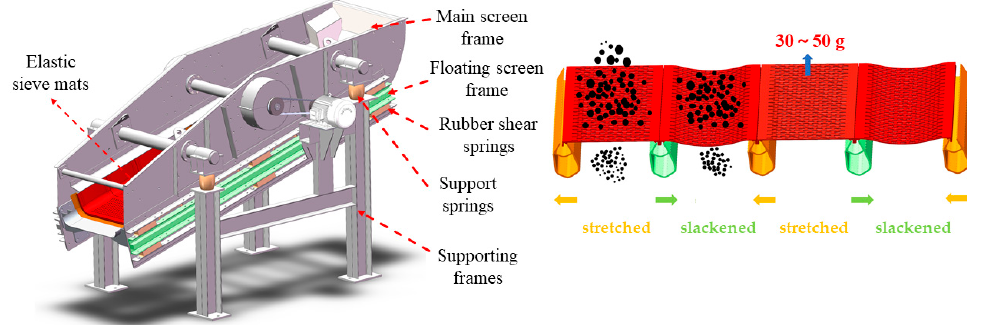
Figure 2. Structures of the VFFS and elastic sieve mat.